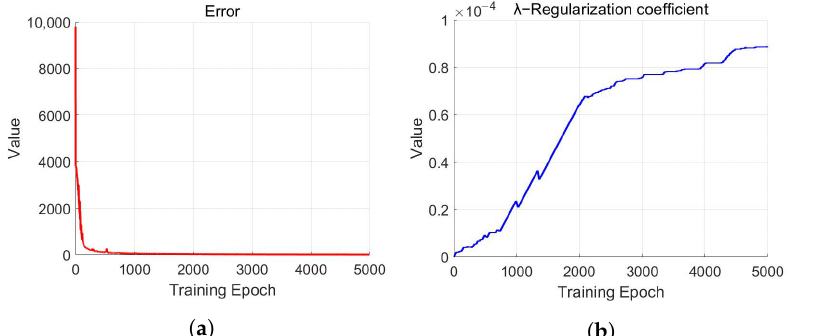
Figure 5. ( a ) Variation of error curve during pruning. ( b ) Variation of regularity coefficients dur- ing pruning.